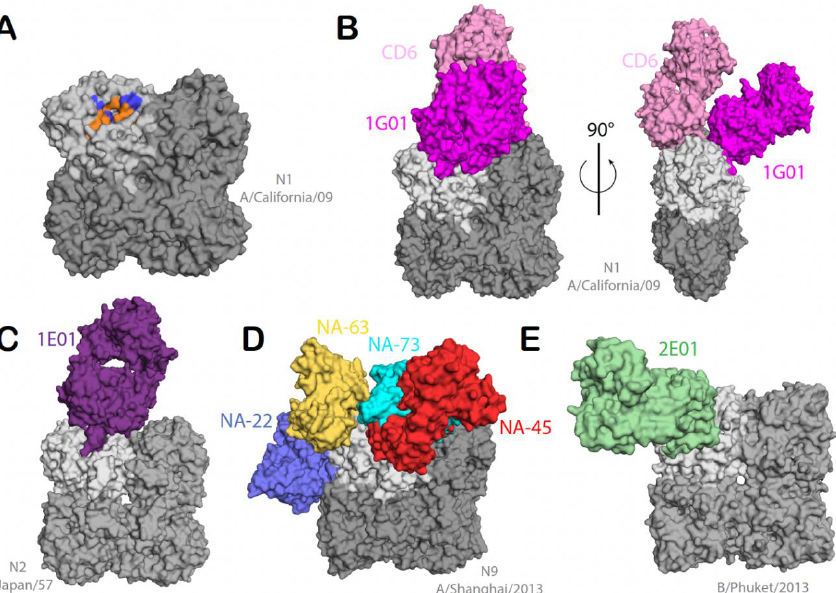
Figure 2. Neuraminidase antibodies target epitopes. ( A ) The NA active site is conserved across subtypes. Orange shows eight functional residues on the active site, and blue shows 11 framework residues on one NA protomer. ( B ) NA protein from H1N1 subtype A/California/04/2009 (grey) in complex with 1G01 Fab (magenta) (PDB: 6Q23) and CD6 Fab (pink) (PDB: 4QNP). ( C ) NA protein from H2N2 subtype A/Japan/305/1957 (grey) in complex with 1E01 Fab (purple) (PDB: 6Q20). ( D ) NA protein from H7N9 subtype A/Shanghai/2/2013 (grey) in complex with NA-45 Fab (red) (PDB: 6PZE), NA-73 (cyan) (PDB: 6PZY), NA-63 (yellow) (PDB:6U02), and NA-22 (blue) (PDB: 6PZW). ( E ) NA protein from influenza B/Phuket/3073/2013 (grey) in complex with 2E01 Fab (green) (PDB: